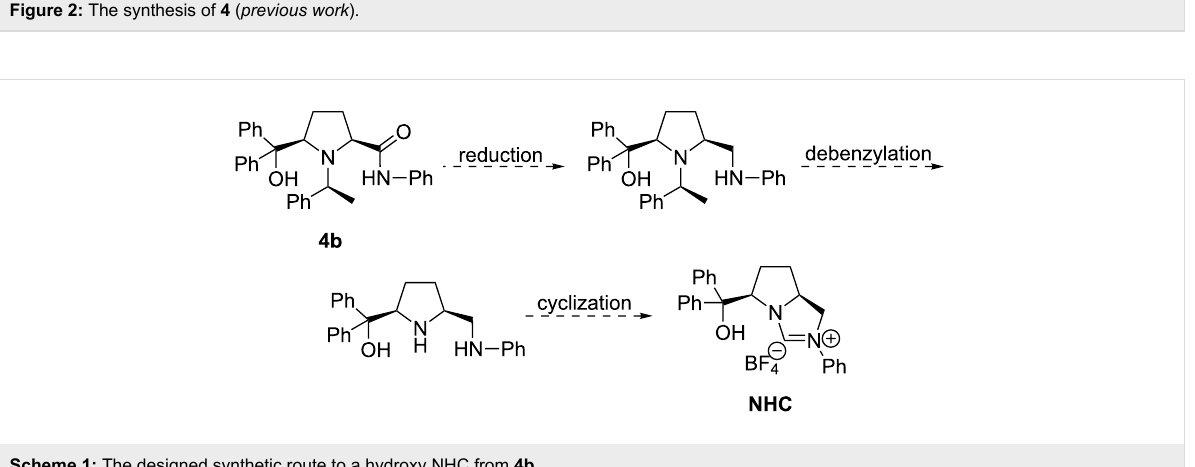
Scheme 1: The designed synthetic route to a hydroxy NHC from 4b .